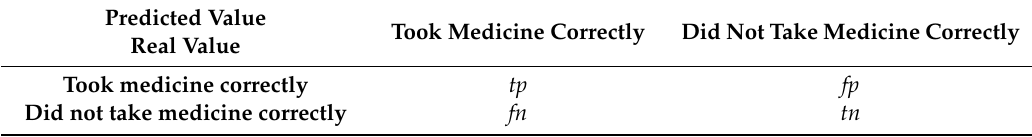
Table 4. Interpretation of tp , tn , fp , and